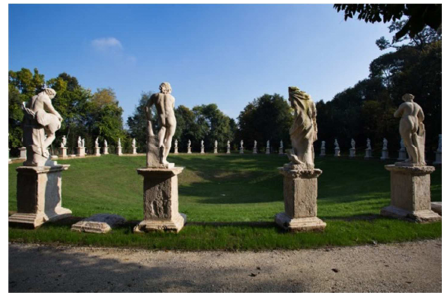
Figure 6: View of the